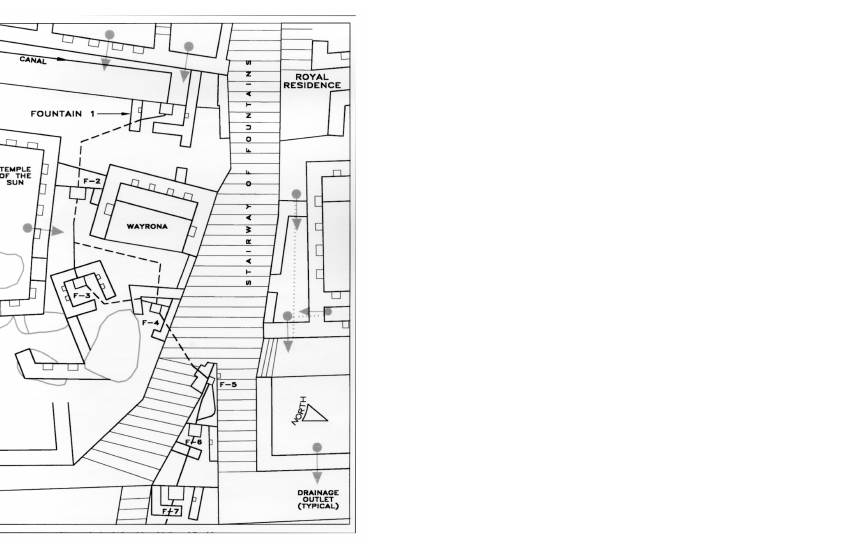
Figure 7. Map of canal and fountains showing relationship to Royal Residence. Fountain #3 (F-3) is the Sacred Fountain. (Reproduced from Machu Picchu: A Civil Engineering Marvel [5], with permission from ASCE, the publisher.)